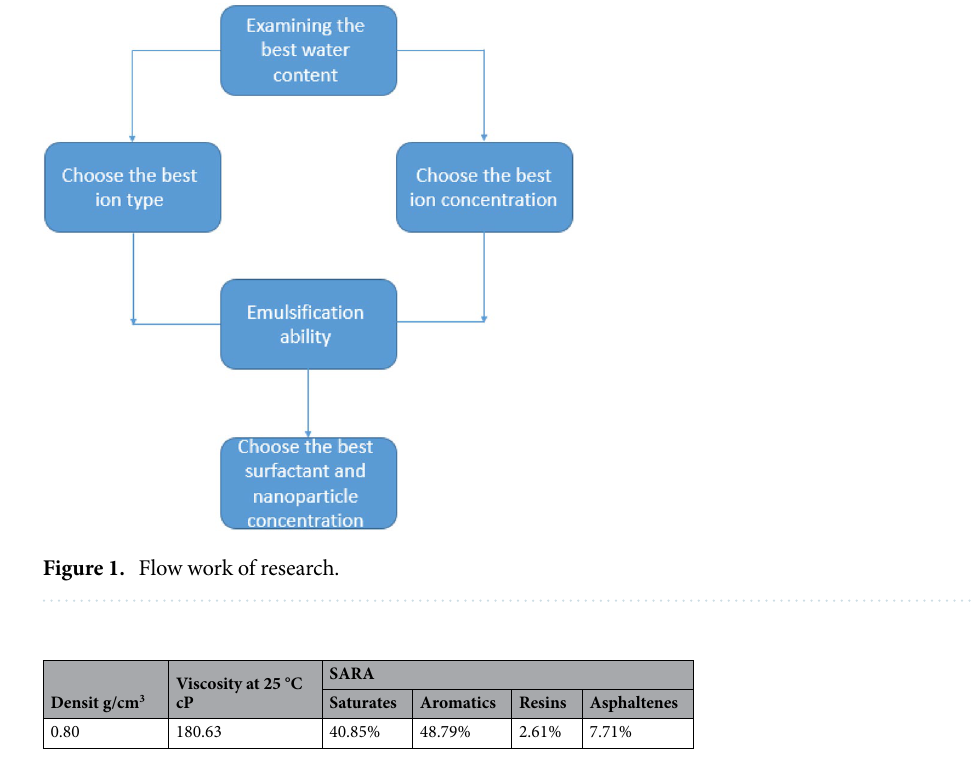
Table 1. Characteristics of the oil.